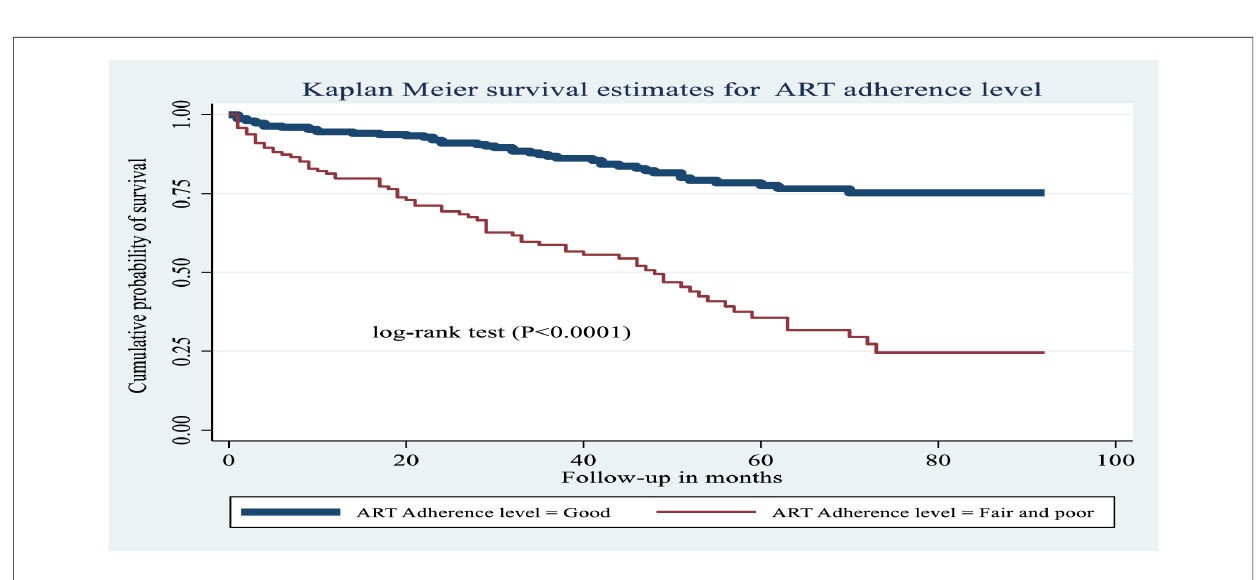
FIGURE 5 Kaplan – Meier estimates of probability of OI-free survival by ART adherence level among HIV-infected children receiving ART at Amhara regional state comprehensive specialized hospitals, Ethiopia,